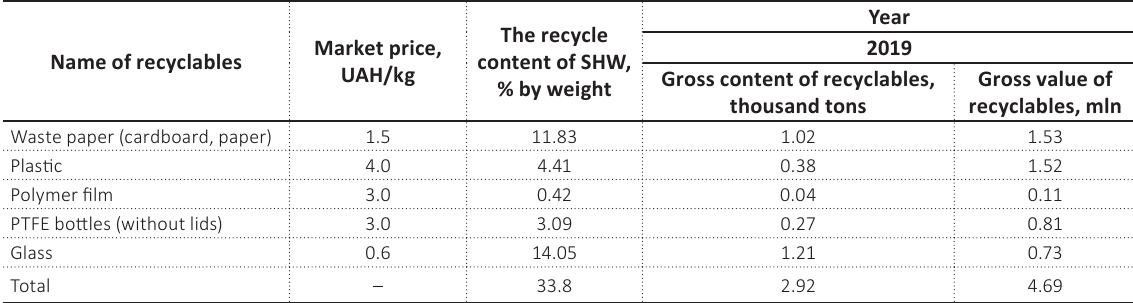
Table 3. Morphological composition of mixed municipal solid waste in Sumy and cost estimate of recyclables in annual volumes of household waste